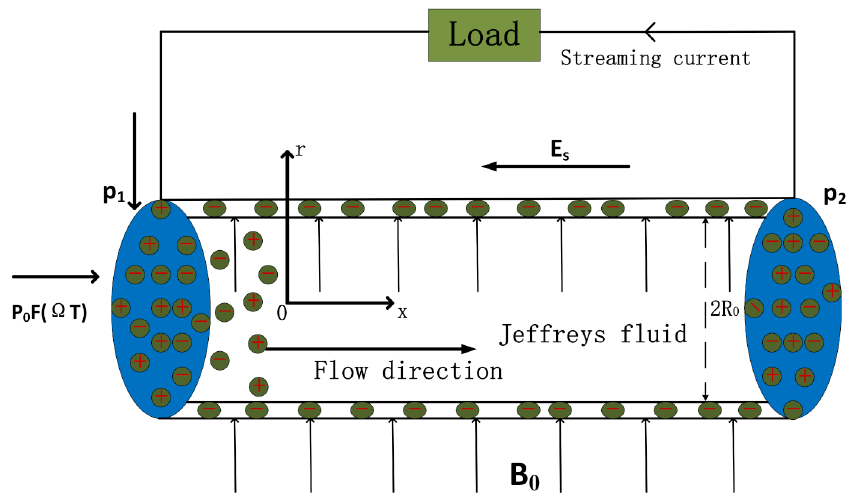
Figure 1. A sort of EKEC